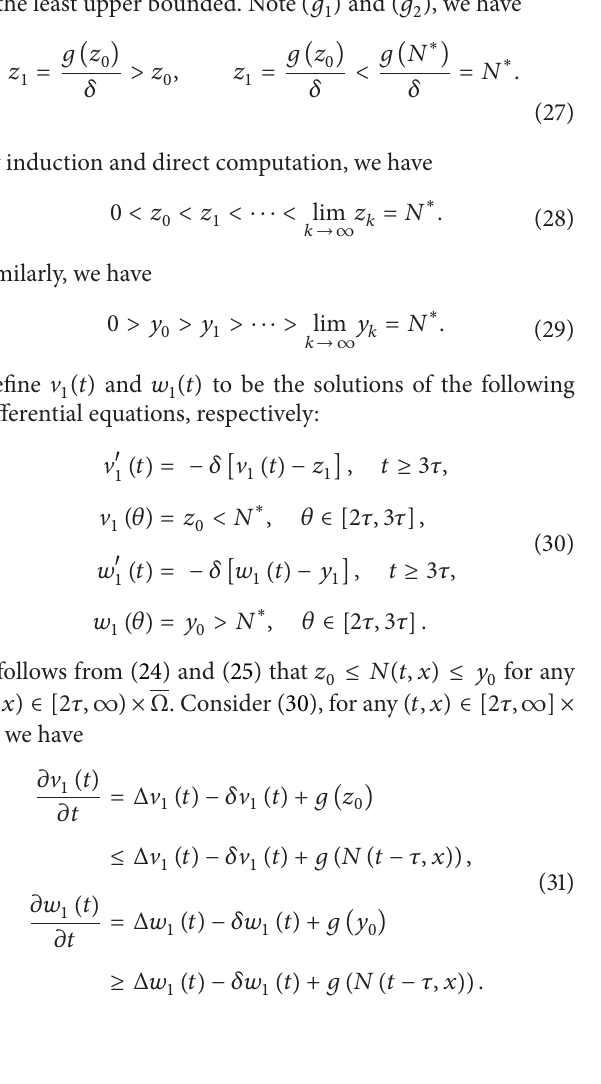
= 15 , and under the 2